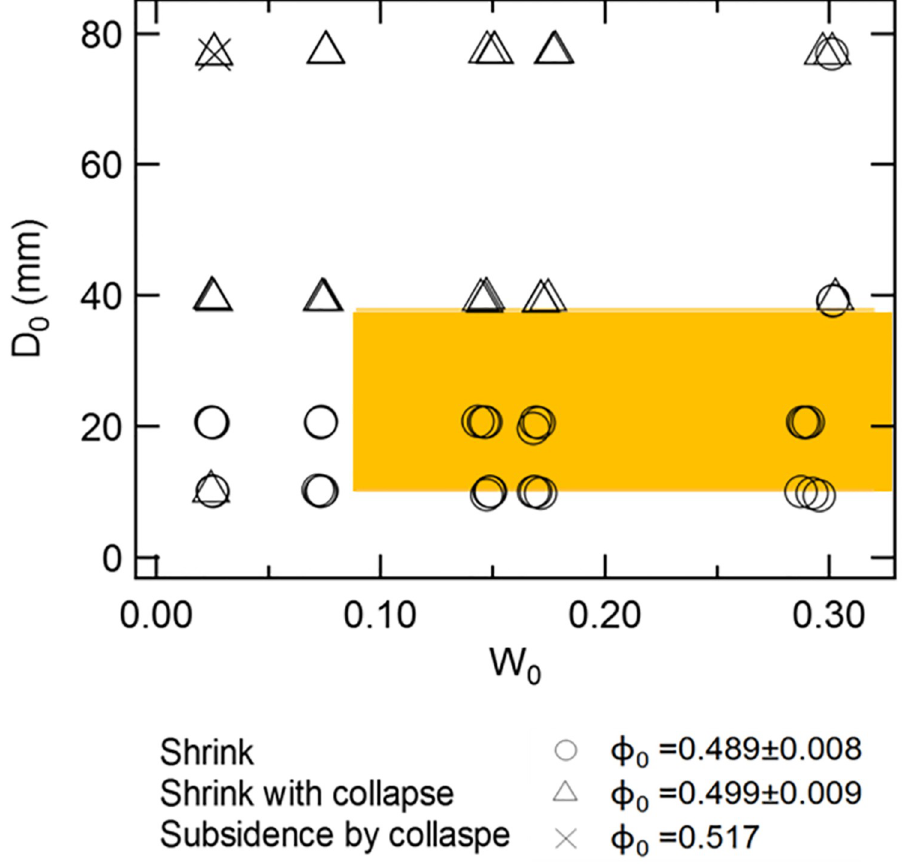
Fig 10. Phase diagram of tunnel deformation/collapse scenarios obtained from experiments with sifted sand collected from the Tsu site ( d < 0.3 mm). Symbols indicate the three modes of tunnel deformation [shrink (circles), shrink with collapse (triangles), and collapse-by-subsidence (ex)]. The mode of tunnel deformation clearly depends on tunnel diameter ( D 0 ) but is almost independent of water content ( W 0 ) as was the case for glass beads [8]. The collapse- by-subsidence scenario is only observed at a water content ( W 0 ) of 0.02 and tunnel diameter ( D 0 ) of about 80 mm. The range of the actual burrow diameters and corresponding water contents is depicted by the yellow rectangle.